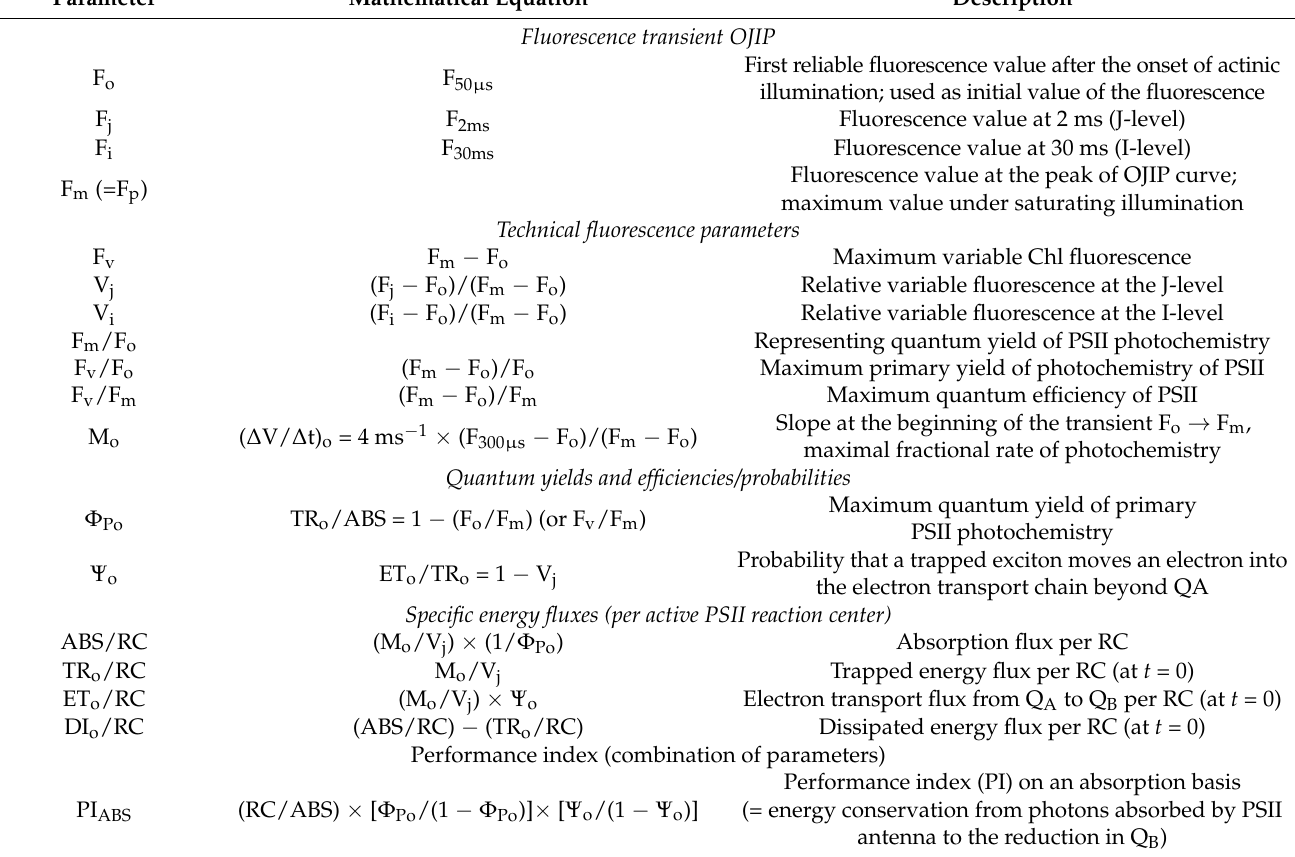
Table 1. Equations and definitions of OJIP parameters (modified from Stirbet and Govindjee [32]). Parameter Mathematical Equation